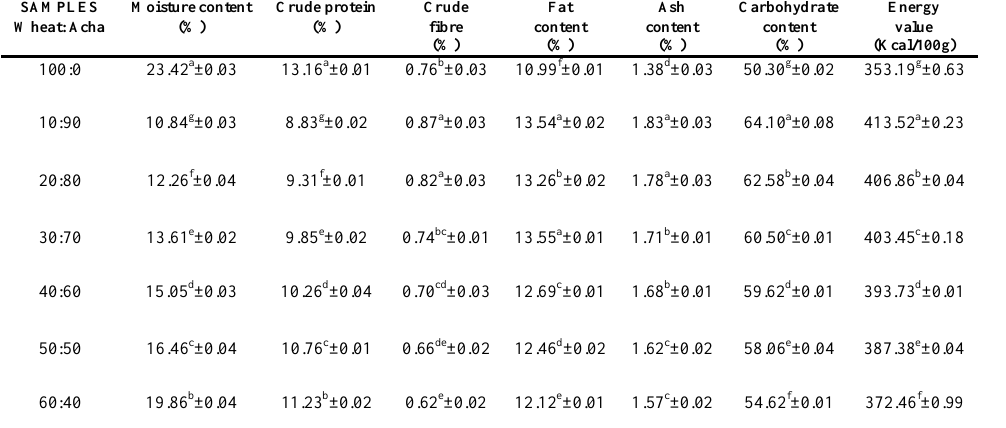
Values are means + standard deviation of duplicate determination. Mean values in the same column with different superscript are significantly different